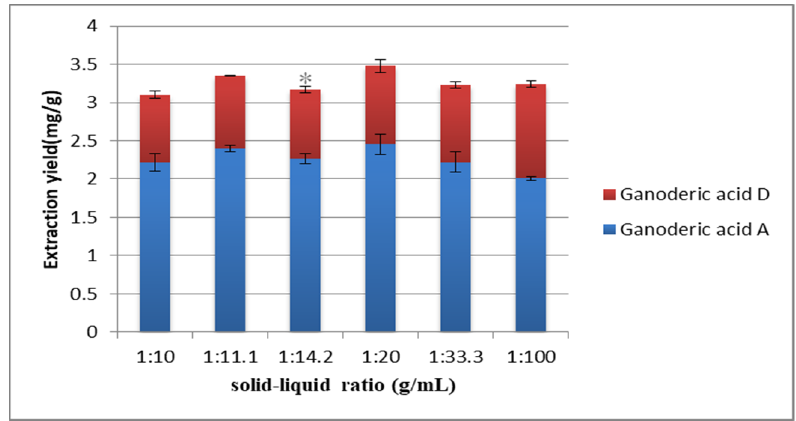
Figure 8. Effect of solid–liquid ratio on the extraction yield. Compared with 1:20 g/mL group: * p < 0.05.